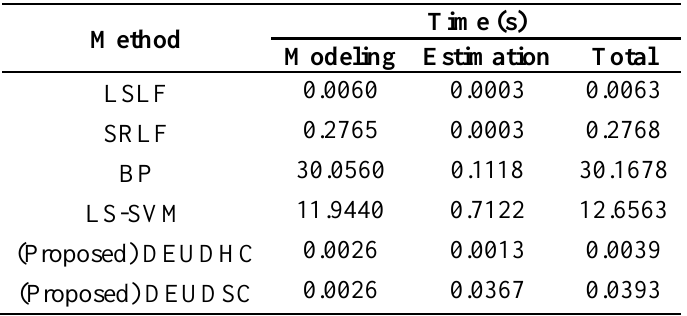
Table 8. Efficiency analysis of different RSSI-D